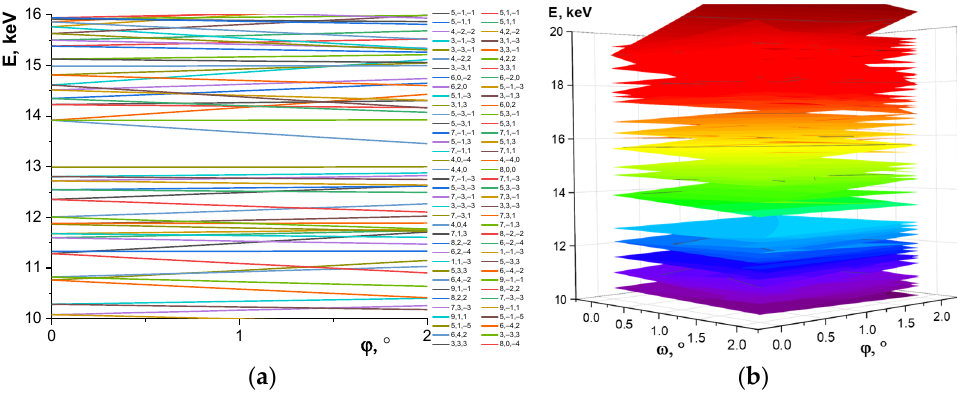
Figure 4. The simulated glitches in a diamond crystal, ( a ) for different angles ϕ and fixed ω = 0°; ( b ) for different angles ω and ϕ .